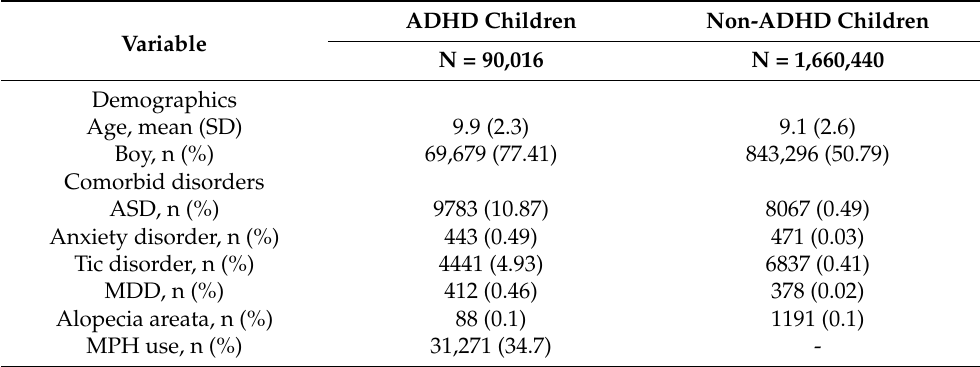
Table 1. Demographic characteristics, comorbid disorders, alopecia areata, and methylphenidate (MPH) use among the included children.